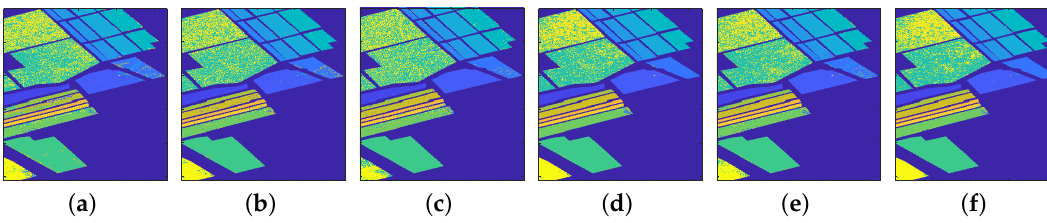
Figure 16. KNN classification maps of using the ten bands selected by different methods from the Salinas dataset. ( a ) MVPCA ( b ) LCMVBCC ( c ) LCMVBCM ( d ) ECA ( e ) OPBS ( f )